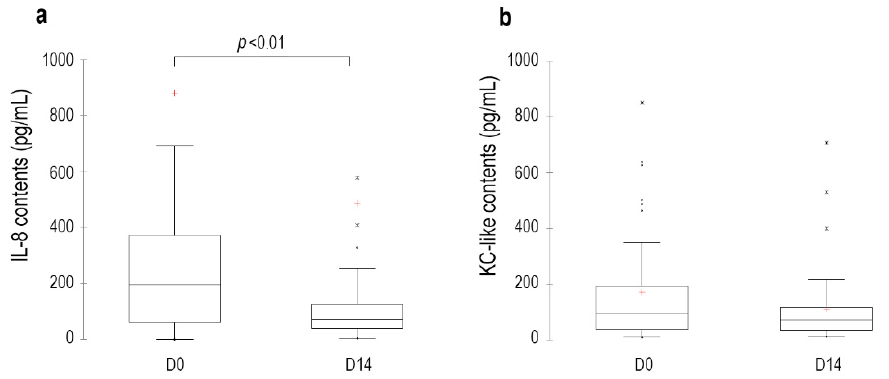
Figure 4. Kinetics of the IL-8 ( a ) and KC-like ( b ) contents in dogs with erythemato-ceruminous otitis externa cleaned with the tested ear cleanser at different time points during the study. Explanation for the box and whisker plots: the top of the box represents the third quartile, the red cross (+) is the mean, the horizontal bar in the box is the median, the bottom of the box is the first quartile and the upper and lower whiskers represent minimum and maximum scores. Dots were considered as outliers.